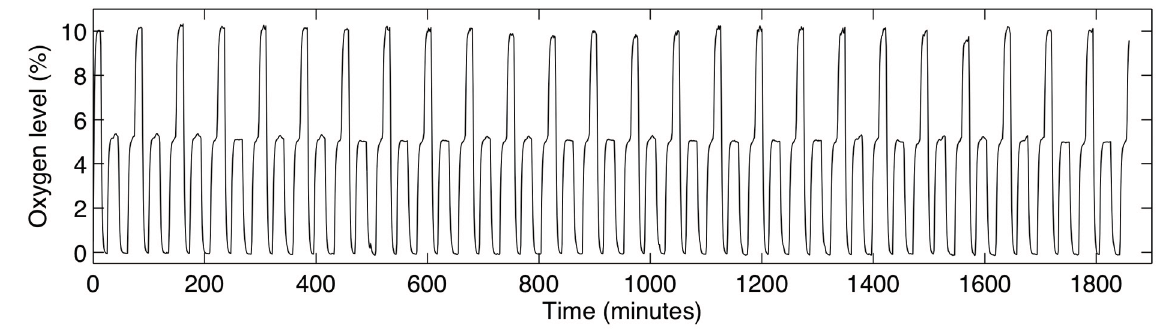
Figure 8. Measured oxygen levels within the cell culture channel during a cyclic, time-varying oxygen profile in the device, lasting 31